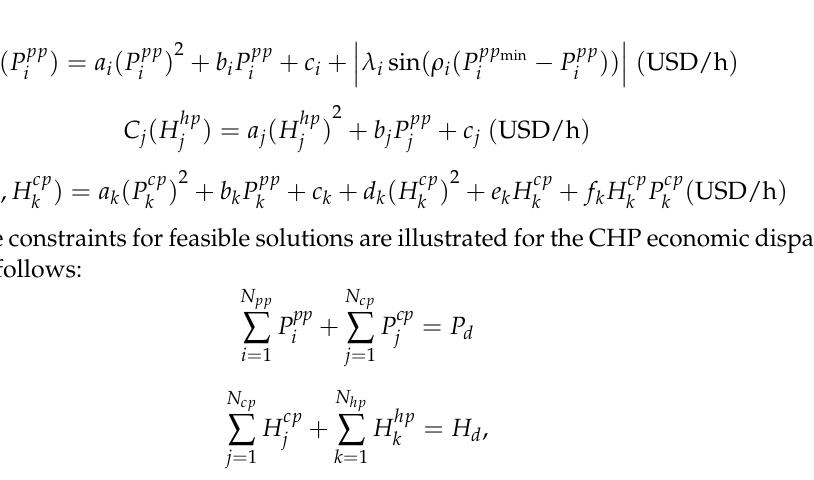
Figure 1. A single line diagram of the CHP economic dispatch problem considering the 24-unit test system.